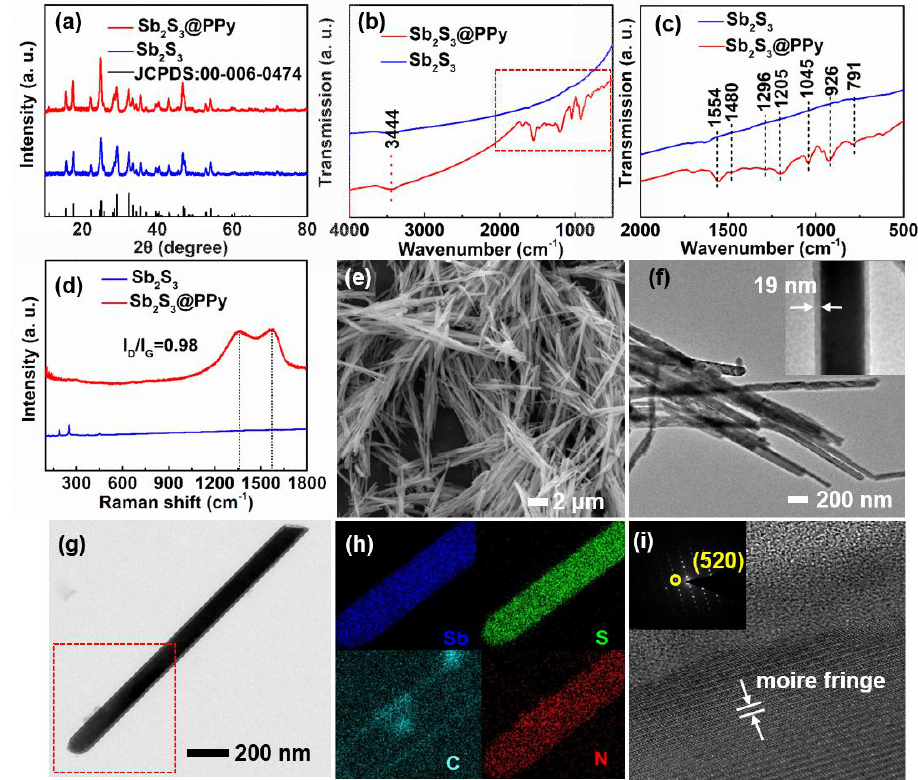
Figure 1. ( a ) XRD patterns of Sb 2 S 3 and Sb 2 S 3 @PPy nanorods. ( b ) FT-IR spectra of Sb 2 S 3 and Sb 2 S 3 @PPy